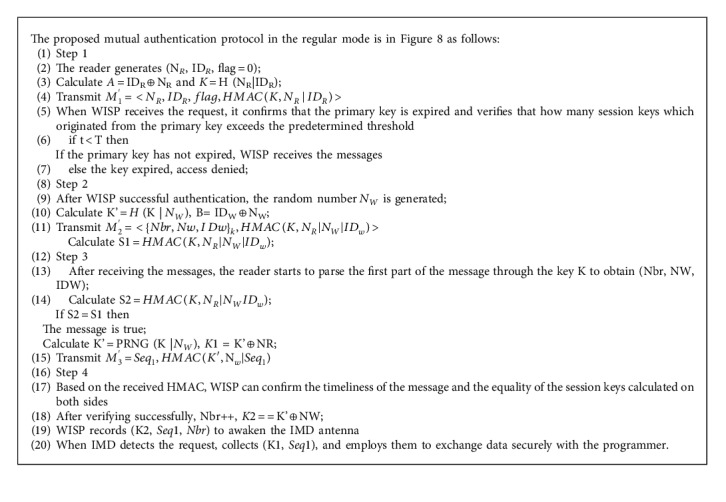
The proposed mutual authentication protocol in the regular mode.